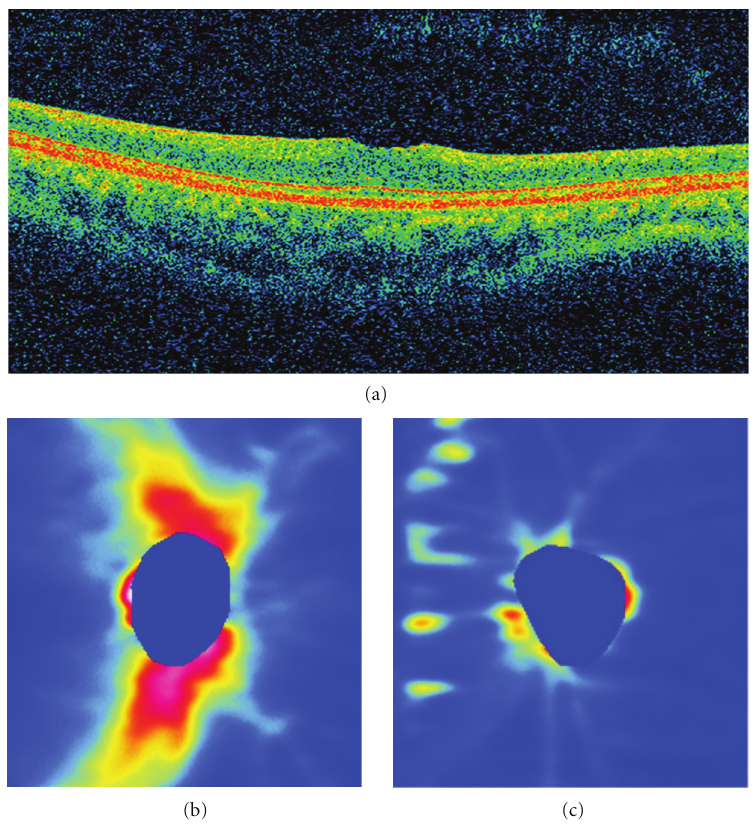
Figure 2: (a) B-scan in the foveal area in a patient with late-stage DUSN presenting a reduced macular thickness and loss of normal foveal contour. RNFL thickness map in the normal eye (b) and a di ff use and pronounced RNFL thinning in the a ff ected eye